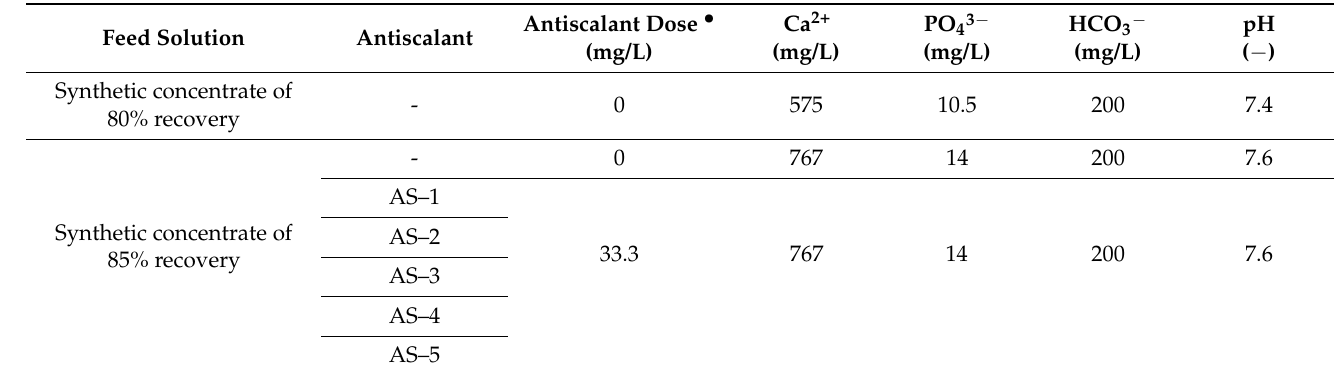
Table 4. Once-through lab-scale RO tests with the synthetic RO concentrates of 80 and 85% recovery in the absence and presence of